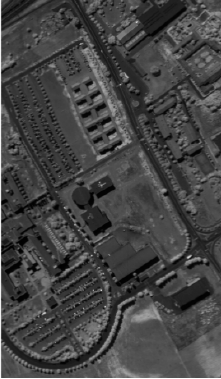
11 of 19 Figure 5. ( a ) Two concatenated images of the Pavia center in Italy. ( b ) Salinas scene of the Salinas valley, California. The Salinas scene from [39], was acquired by the AVIRIS sensor over Salinas Valley, California, with 224 spectral bands from 400 (cid:2924)(cid:2923) to 2500 (cid:2924)(cid:2923) and with 512 × 217 spatial pixels. The spectra intensity was normalized to be between 0 to 1. The dataset was augmented by injecting Gaussian noise with standard deviation (STD) 𝜎 = 0.001 . Then, the HS cube was divided into a training set, which includes the spectra of 70% of the spatial pixels, and a test set, which includes 30% of the pixels. The data of the Pavia center dataset has a wider variance than that of the Salinas valley dataset. In Sections 3.3–3.5, it can be seen that very few spectra in the dataset are needed to reconstruct the Salinas valley dataset (only 111,104 spectra in the HS cube) with better reconstructions than in the Pavia center and Pavia University (Section 3.2.) datasets (Pavia center includes 1,201,216 spectra in its HS cube), even though its compression ratio is twice smaller. This is due to the tight variance of its data compared to the variance of spectra in the Pavia center and Pavia University datasets. 3.1.2. Pavia University—Generalization Evaluation In Section 3.1.1, we trained the PyCAE on 70% spectra of one dataset (Pavia center or Salinas valley) and validated and tested it on the remaining 30% spectra. Because many of the spectra are from the same materials under evaluation, they are almost the same, with small deviations inside each group of materials. For this reason, they show a particularly good reconstruction performance.